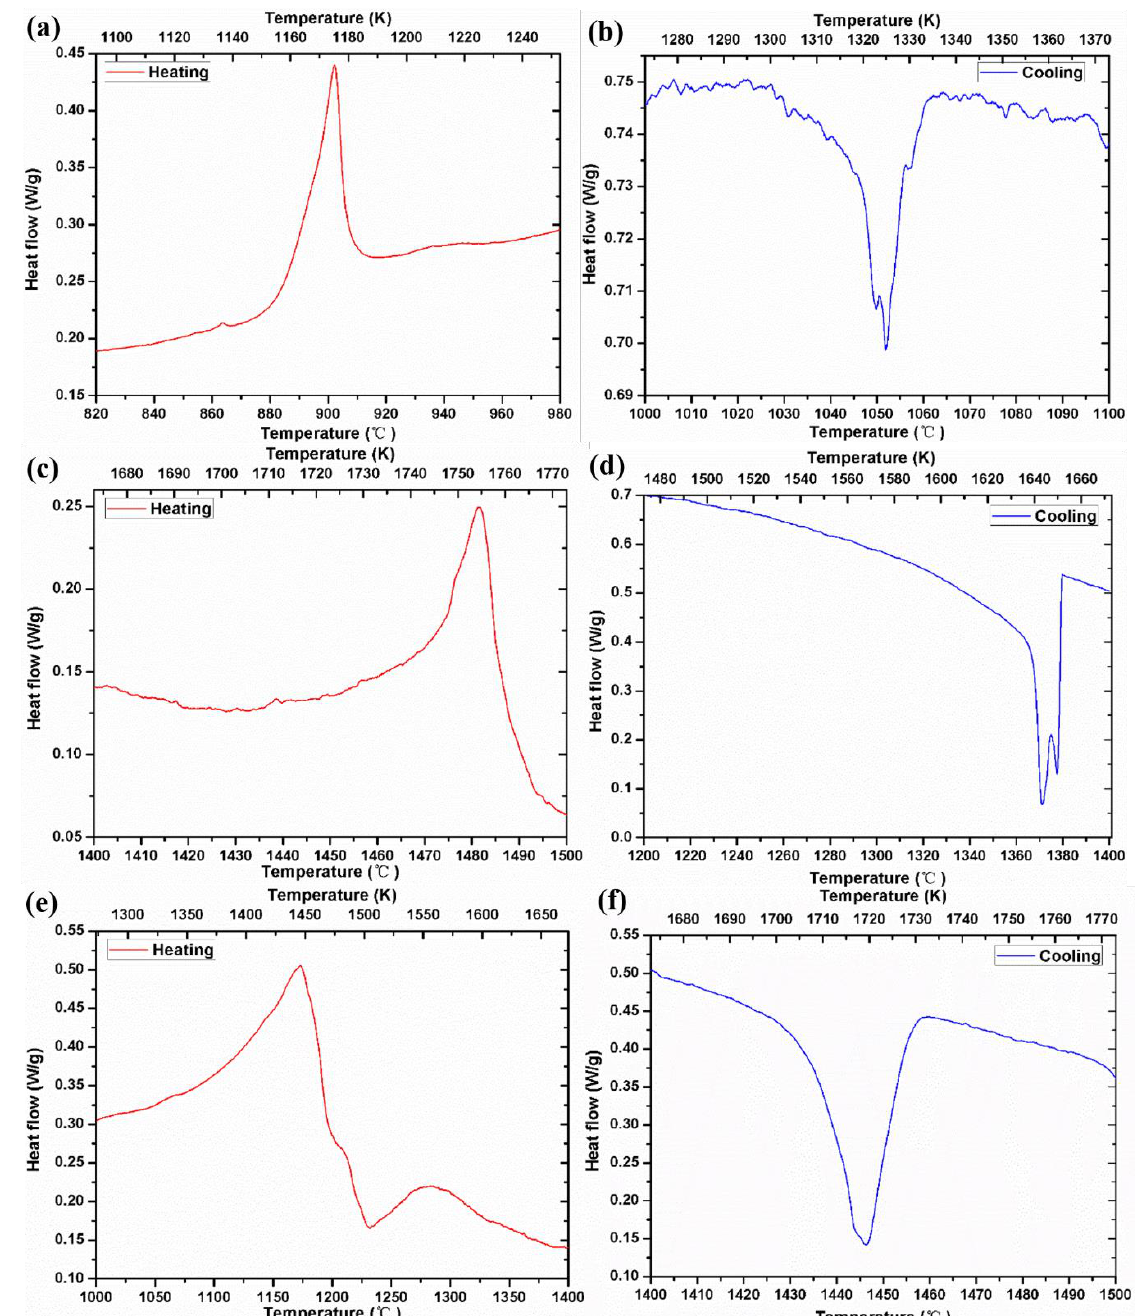
Figure 12. Magnified peak areas of high M s Ti-Ni-Hf-Cu-Nb DSC curves ( a ) the endothermic/melting peak of the lowest melting phase during heating, ( b ) the exothermic/solidification peak of the lowest melting phase during cooling, ( c ) the endothermic/melting peak with the highest transformation energy phase during heating, ( d ) the exothermic/solidification peak with the highest transformation energy phase during cooling, ( e ) the endothermic/melting peak of the highest melting point phase during heating, ( f ) the exothermic/solidification peak with the highest melting point phase during cooling.